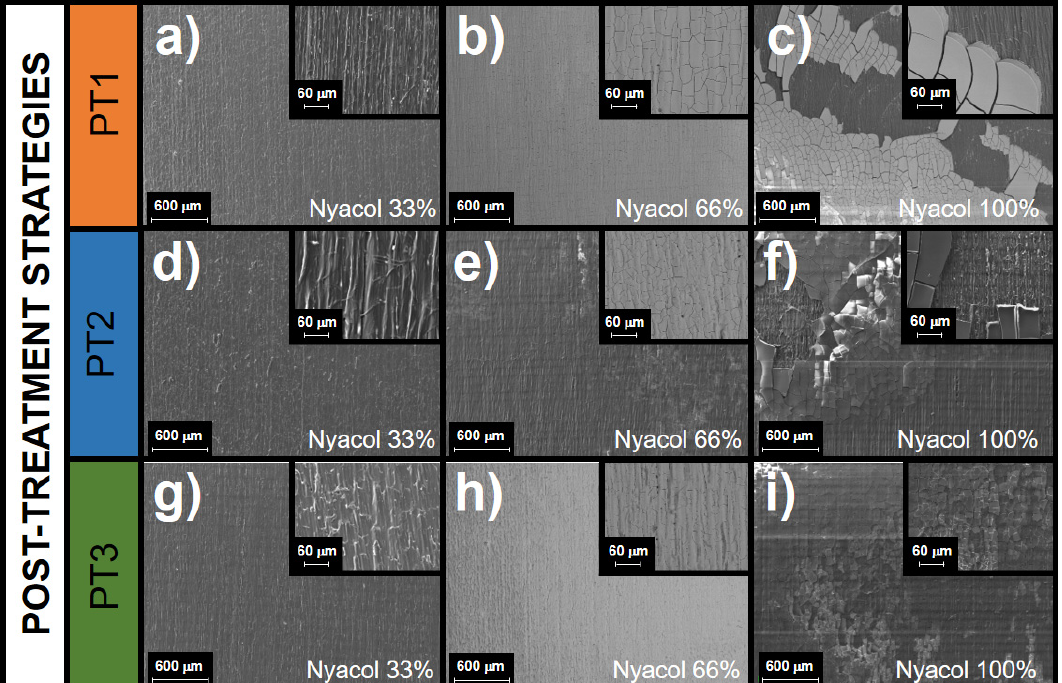
Figure 6. SEM micrographs of the coated plates with the different concentrations of Nyacol: Post- treatment strategies: ( a ) PT1 Nyacol 33%, ( b ) PT1 Nyacol 66%, ( c ) PT1 Nyacol 100%, ( d ) PT2 Nyacol 33%, ( e ) PT2 Nyacol 66%, ( f ) PT2 Nyacol 100%, ( g ) PT3 Nyacol 33%, ( h ) PT3 Nyacol 66%, ( i ) PT3 Nyacol 100%,